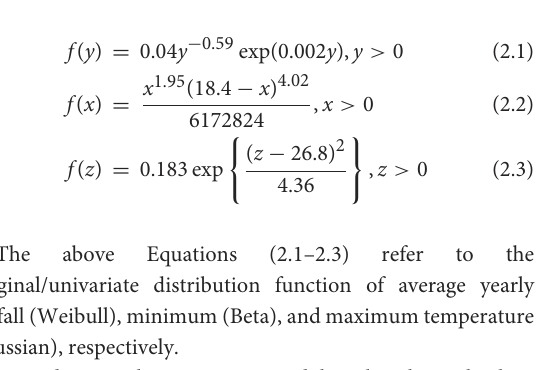
2.95, β 5.02 and a = = = 26.8, σ 2.189) = =